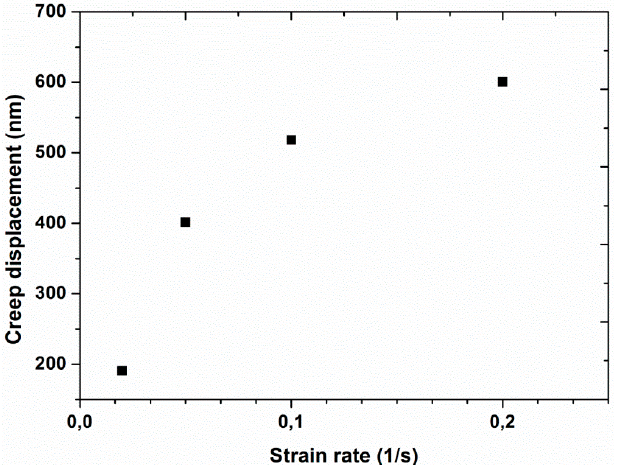
Figure 10. Creep displacement as a function of strain rate at a constant frequency of 45 Hz and an amplitude of 2 nm.